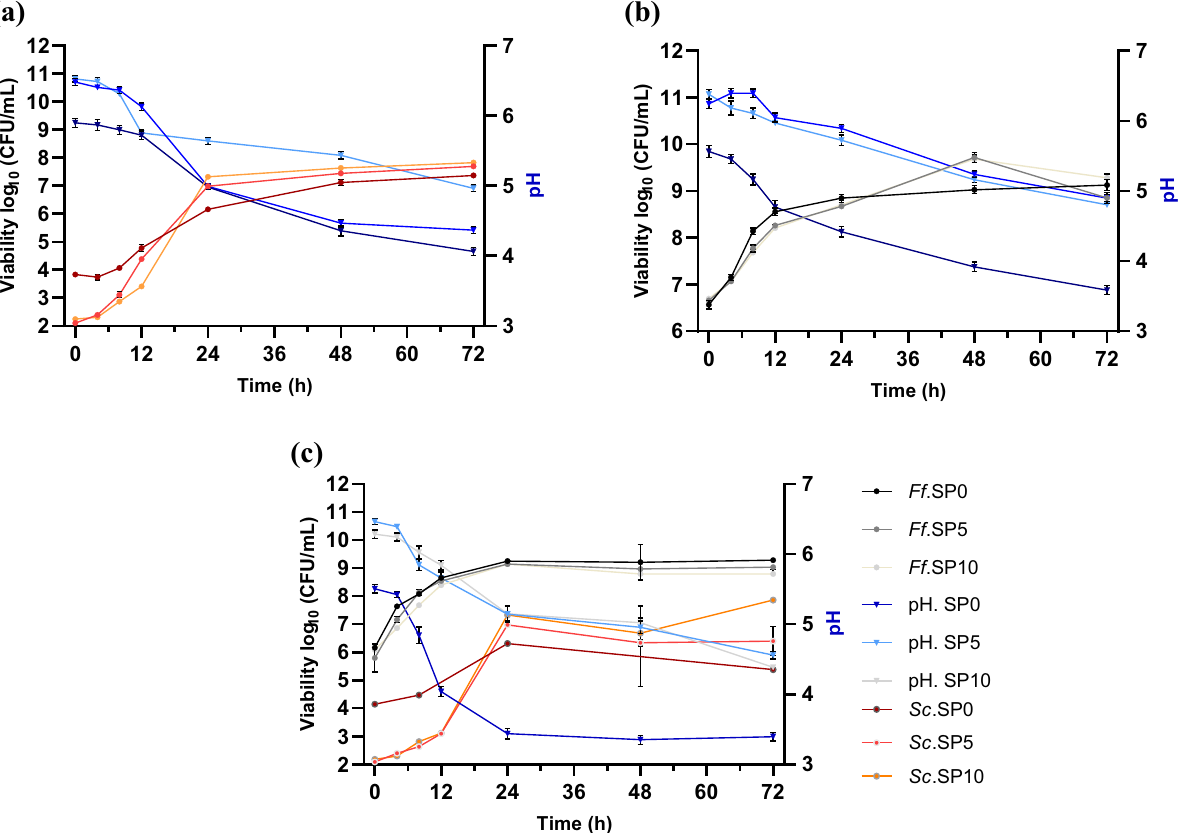
Figure 1. Viable cell counts (red and black lines) and pH profile (blue lines with triangles) of dough fermented with ( a ) S. cerevisiae (red lines with squares), ( b ) F. florum (black lines with dots), and c . F. florum + S. cerevisiae . Viability and pH values are displayed as the mean values ± SD, log 10 CFU/mL, n = 3, GraphPad Prism Version 8.0.1 (Graph Pad Software, Inc., San Diego, CA, USA); CFU/mL (colony-forming units/milliliter of the